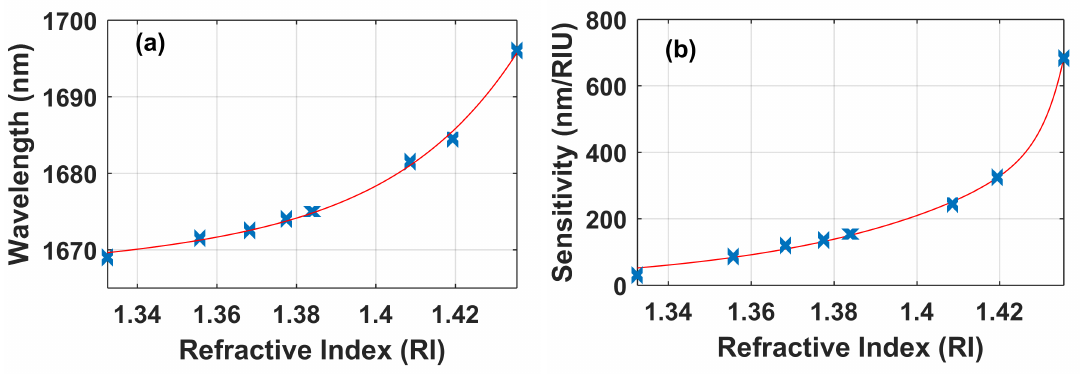
Figure 6. The wavelength of the transmission minima for a 20.0 mm long TCF sensor submerged in solutions with different RI ( a ) and the sensitivity in nm per RIU as a function of RI ( b